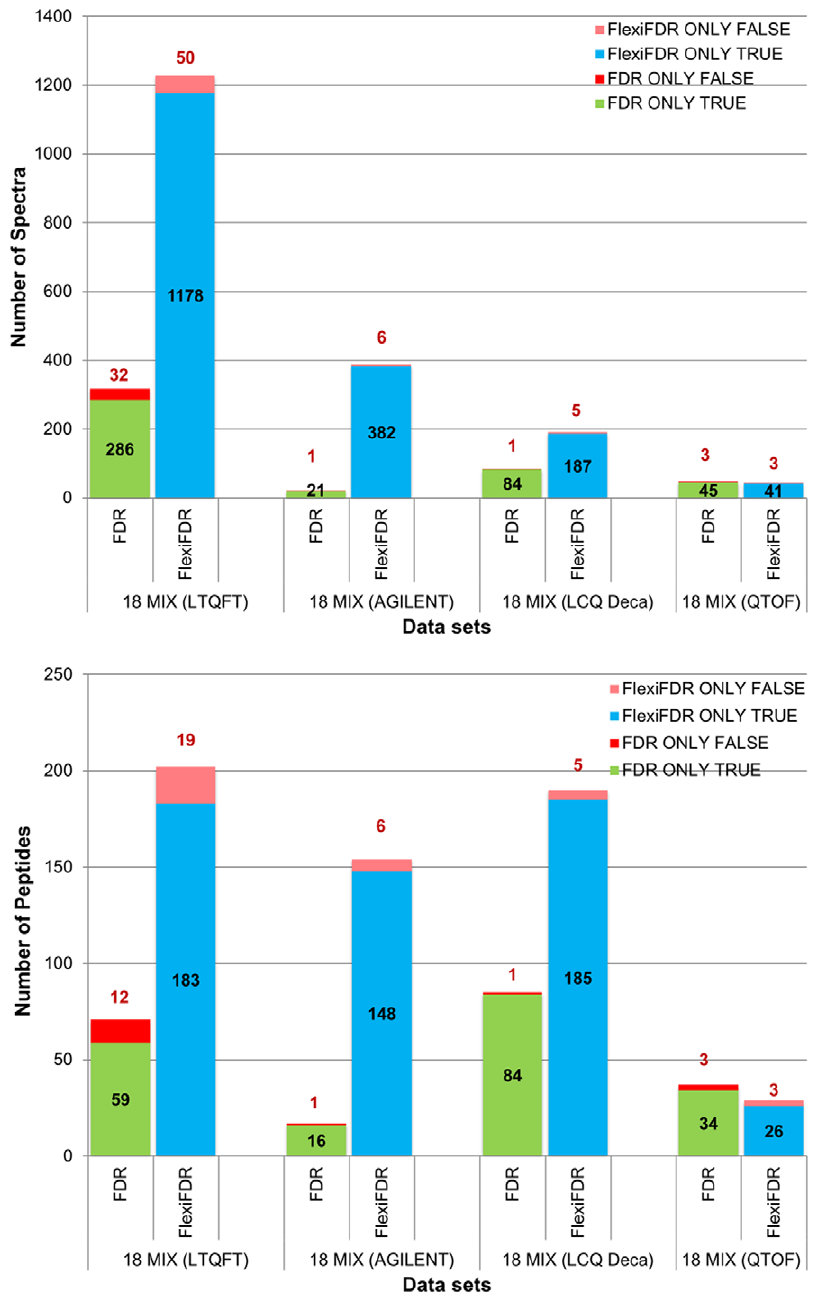
Figure 6. FlexiFDR on Mascot concatenated searches. FlexiFDR was also applied to Mascot and results for concatenated searches are shown for the unique identifications in some standard mix datasets. Except for QTOF, the other datasets showed improvement in number of spectra and peptide identifications.